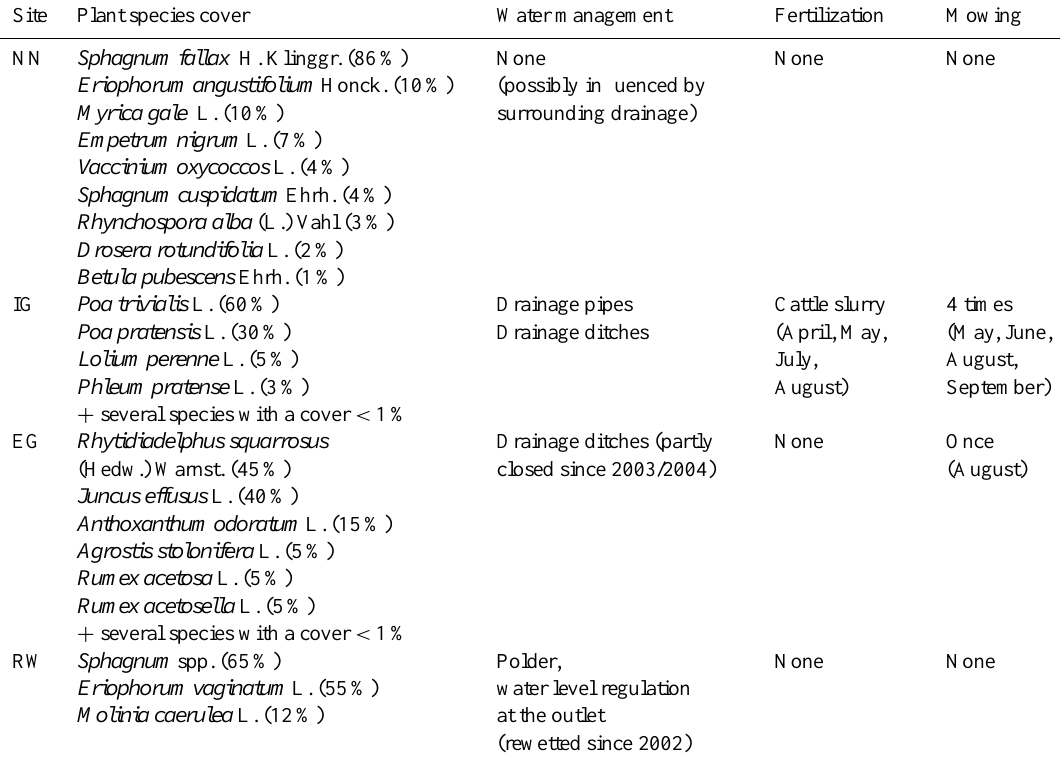
Table 1. Plant species and species cover in brackets, water management, and agricultural management of the study